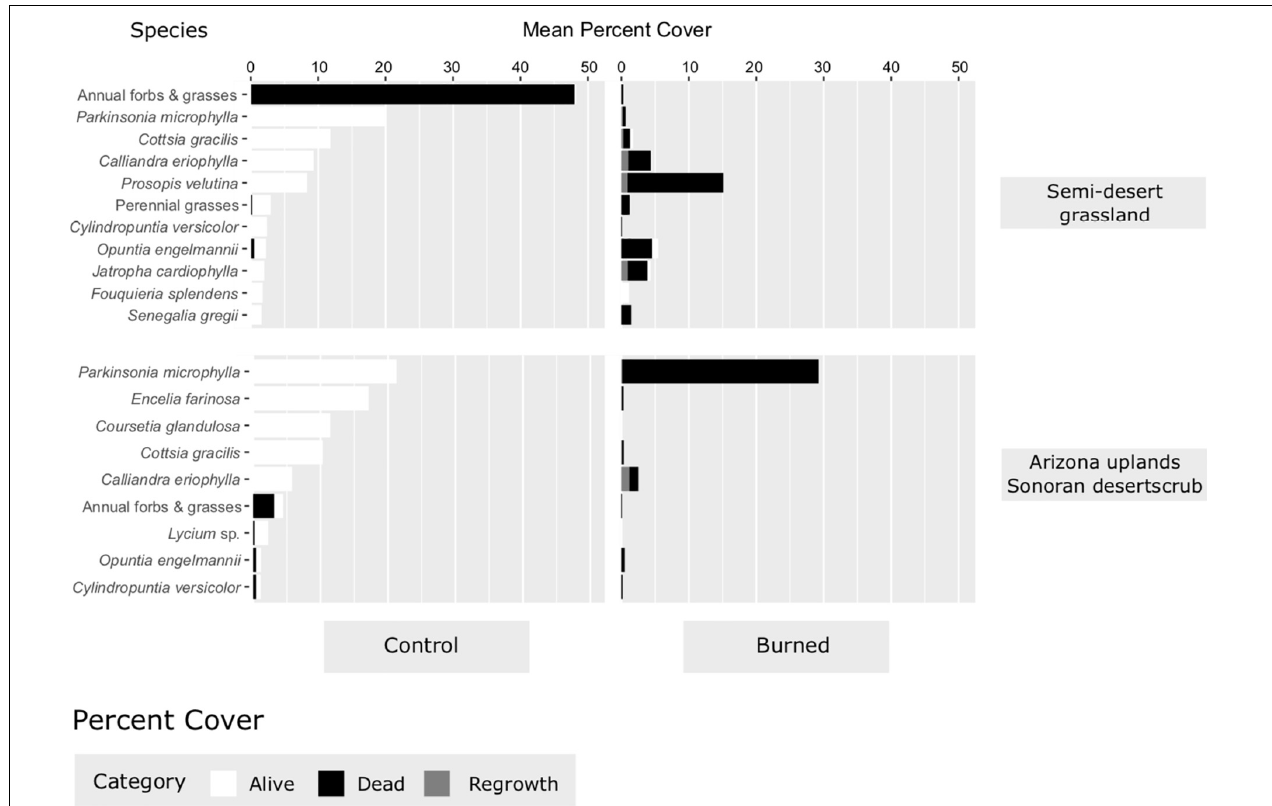
FIGURE 8 | Percent cover of the most prominent species in burned and control plots, Catalina State Park, Tucson,